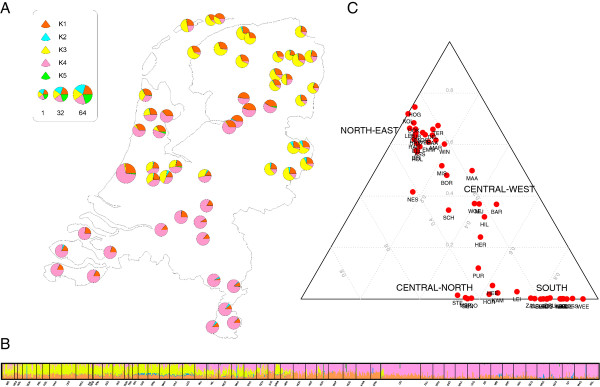
Admixture analysis of the Dutch samples. A) Pie chart map of the genome-wide ancestry assignment in the 54 Dutch subpopulations estimated with 10 independent runs by ADMIXTURE [26] using K = 5 assumed parental populations. B) Individual ancestry estimated by ADMIXTURE using K = 5. C) Ternary plot of subpopulations using the three most frequent (K1, K3, K4) categories identified by ADMIXTURE. For subpopulations see Table 1 and Figure 2.